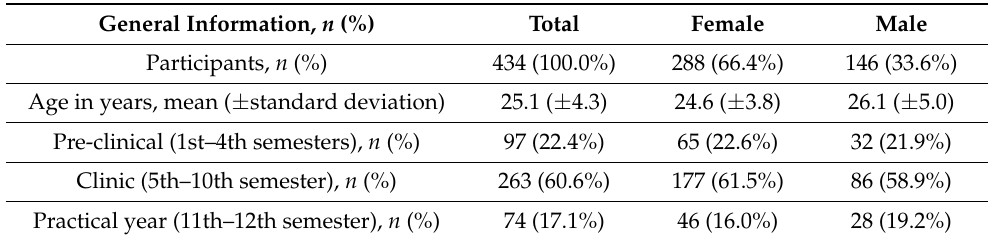
Table 1. Description of the KARiMED study participants from study arm XI ( n = 434). General Information, n (%) Total Female Male Participants, n (%) 434 (100.0%) 288 (66.4%) 146 (33.6%) Age in years, mean ( ± standard deviation) 25.1 ( ± 4.3) 24.6 ( ± 3.8) 26.1 ( ± 5.0) Pre-clinical (1st–4th semesters), n (%) 97 (22.4%) 65 (22.6%) 32 (21.9%) 263 (60.6%) 177